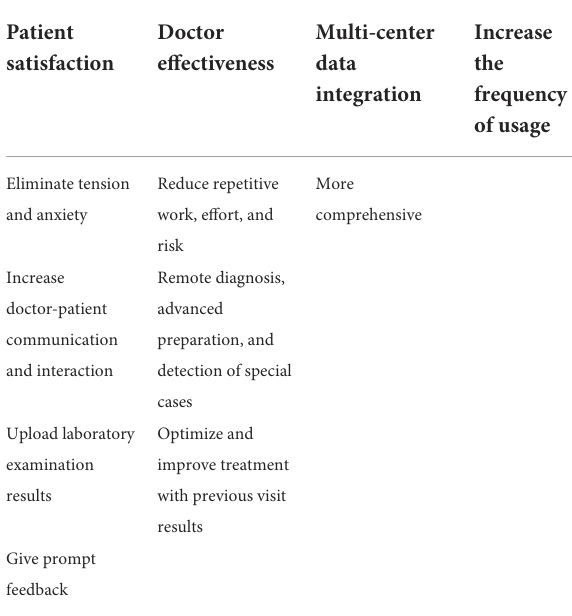
TABLE 4 The usability assessment of the mobile system ( N =